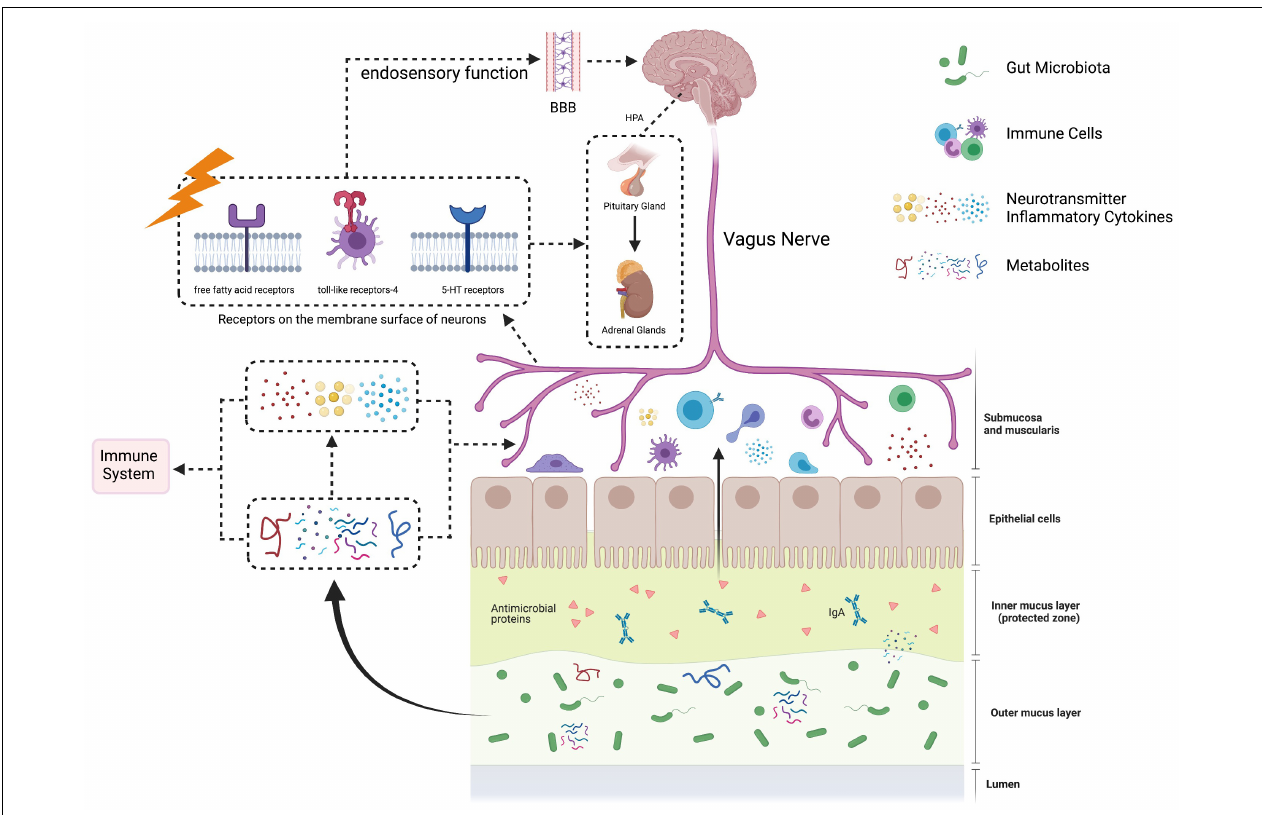
FIGURE 1 | The paradigm of gut-brain axis. The gut-brain axis, referring to the signals’ bidirectional communication between gut microbiota and the brain, is mediated by neuronal, immune, and neuroendocrine pathways. In the gastrointestinal tract, certain gut microbiota can produce neuroactive substances, such as dopamine, serotine and short-chain fatty acids. Signals from abnormal gut microbiota and its metabolites can be sensed and transported by afferent fibers of vagus nerve into the brain. In addition, the integrity of gut barrier is disrupted to form the “leaky gut,” which facilitates gut microbiota-derived components and metabolites to enter the circulatory system. These substances can directly or indirectly activate the immune system to release inflammatory factors. Under the state of immune dysfunction, the permeability of the blood–brain barrier (BBB) is increased. Inflammatory factors and neuroactive substances produced by gut microbiota go through the BBB, leading to neuroinflammatory, activating the hypothalamus-pituitary-adrenal (HPA) axis and disrupting brain